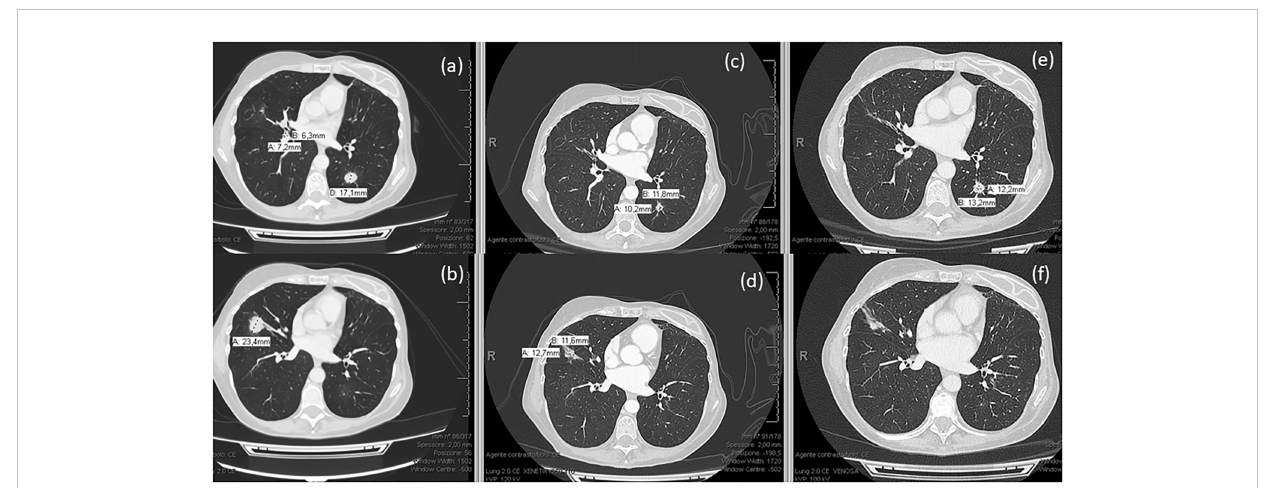
FIGURE 2 Radiological evaluation of the patient ’ s lung metastases (A, B) before, (C, D) after 3.5 months, and (E, F) after 7 months of treatment with sacituzumab